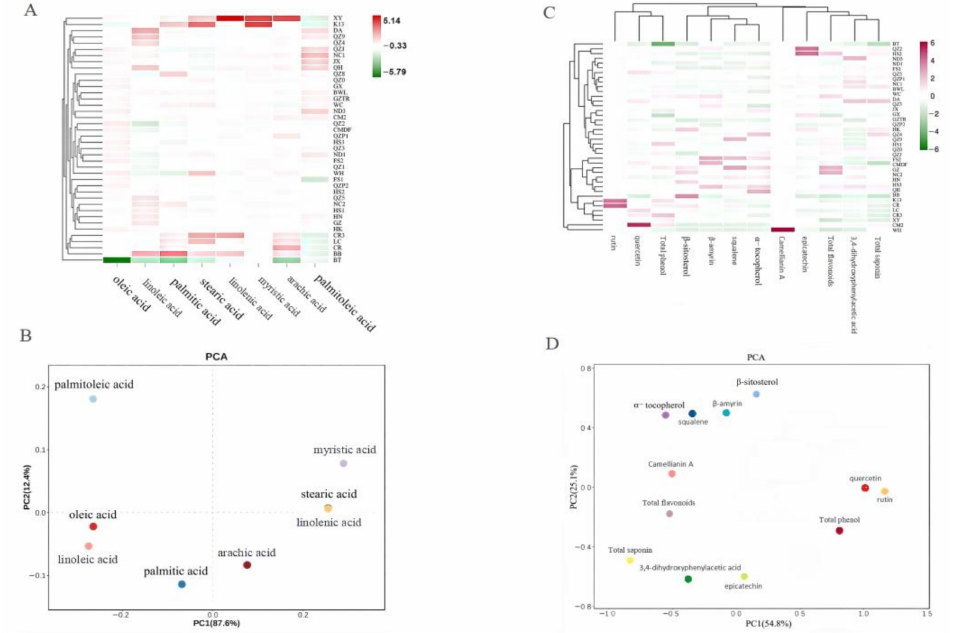
Figure 3. ( A ): The heatmap of fatty acids in Camellia spp., respectively; ( B ): The PCA analysis of fatty acids in Camellia spp., respectively; ( C ): The heatmap of active content in Camellia spp., respectively; ( D ): The PCA analysis of active content in Camellia spp.,